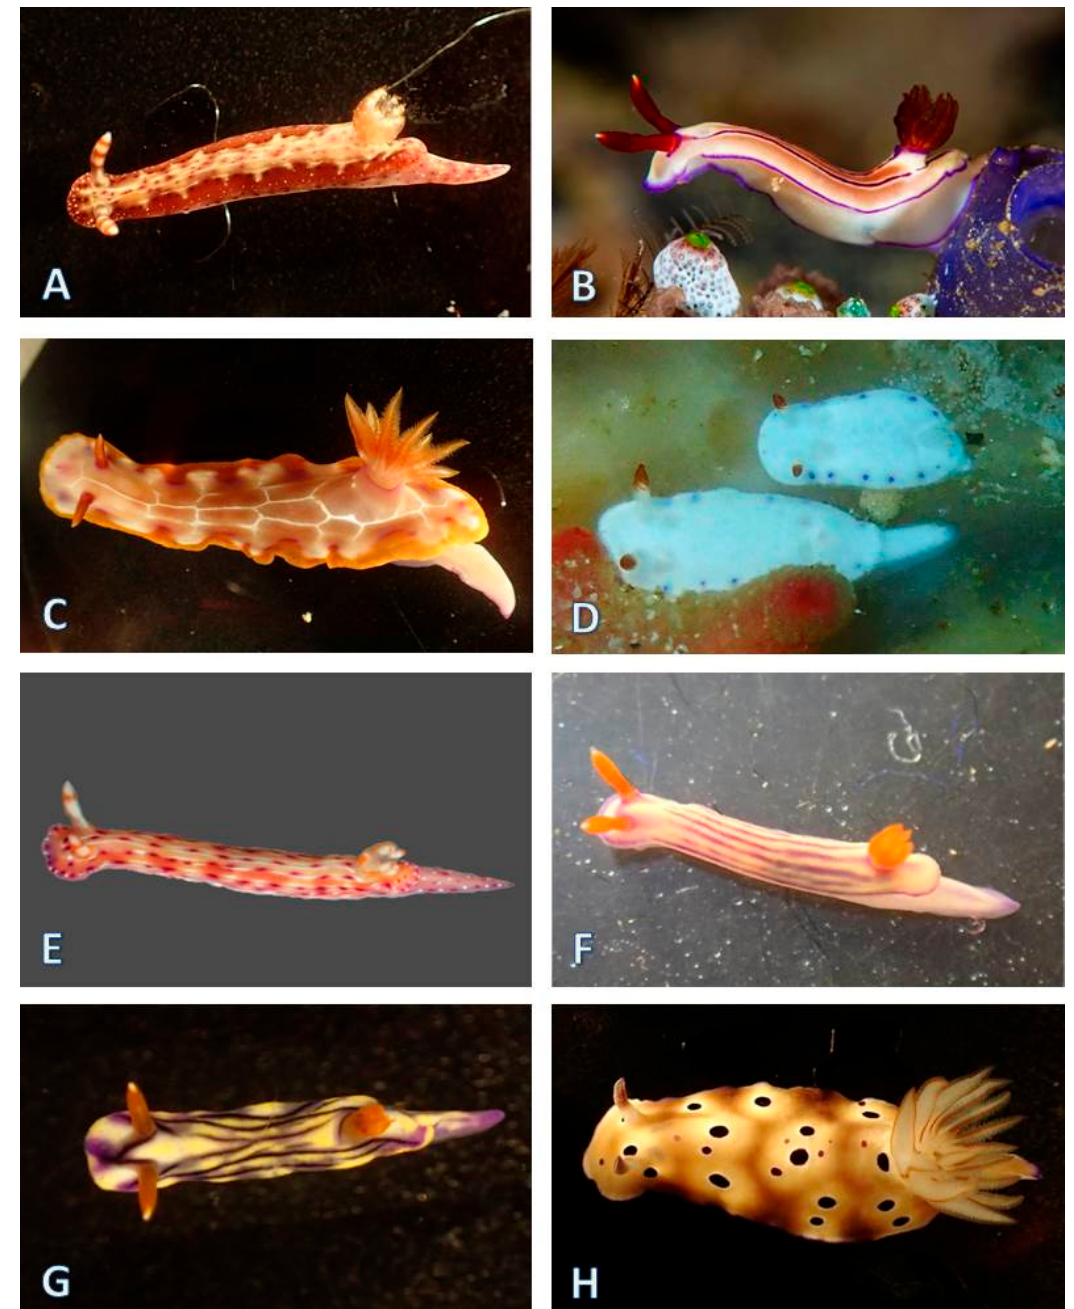
Figure 14. Nudibranchia Doridina: ( A ) Hypselodoris decorata, Hyma18Ba-1; ( B ) Hypselodoris emma *; ( C ) Hypselodoris iacula , Chromos18Ba-1; ( D ) Hypselodoris lacuna , Hysp19_17Ba-1-2; ( E ) Hypselodoris maculosa , Hyma17Ba-1; ( F ) Hypselodoris maridadilus , Hymari17Ba-1; ( G ) Hypselodoris zephyra , Hyni18Ba-1; ( H ) Hypselodoris tryoni , Hytr18Ba-5. *Specimen not collected.